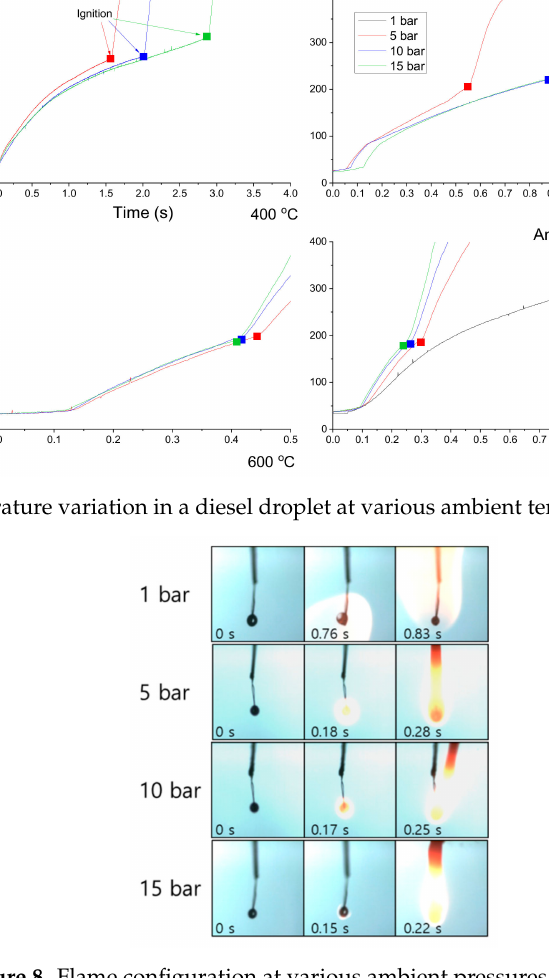
Figure 8. Flame configuration at various ambient pressures and 700 ◦ C.